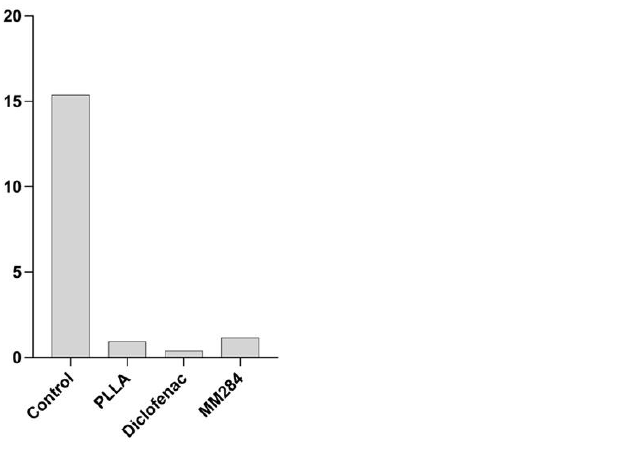
Figure 9. DEX concentration in perilymph. Results are from pooled samples of each group (Control, PLLA, Diclofenac, MM284). Means of double determination are